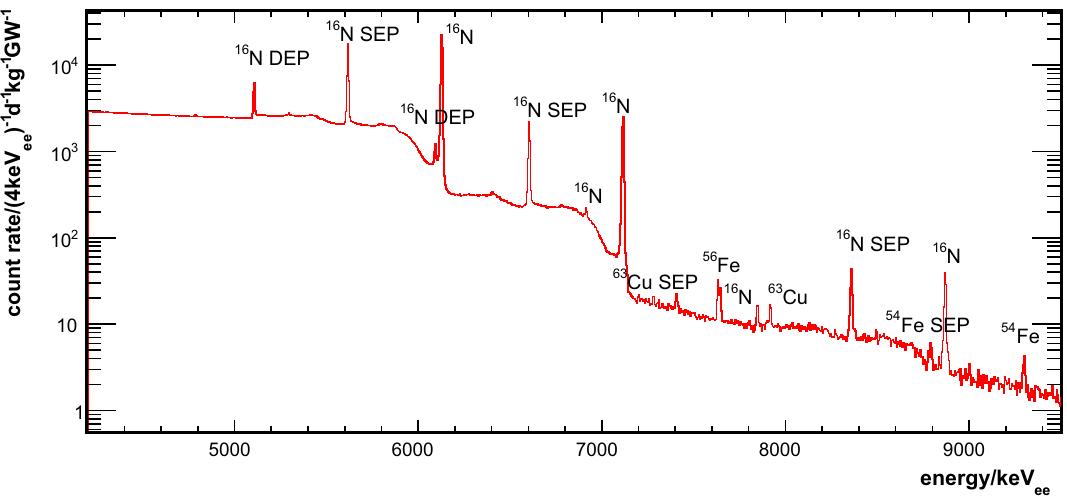
Fig. 22 Spectrum of CONRAD detector inside A408 without any shield above 2700keV dominated by thermal power correlated contributions. The spectrum is normalized to the mean reactor power. For the strongest lines the decaying isotope is